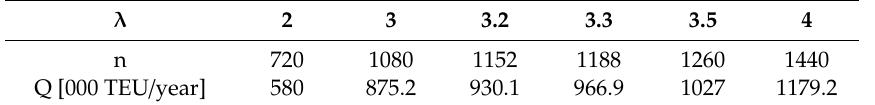
Table 2. The relation between frequency of arrivals ( λ ) and total annual throughput for generated